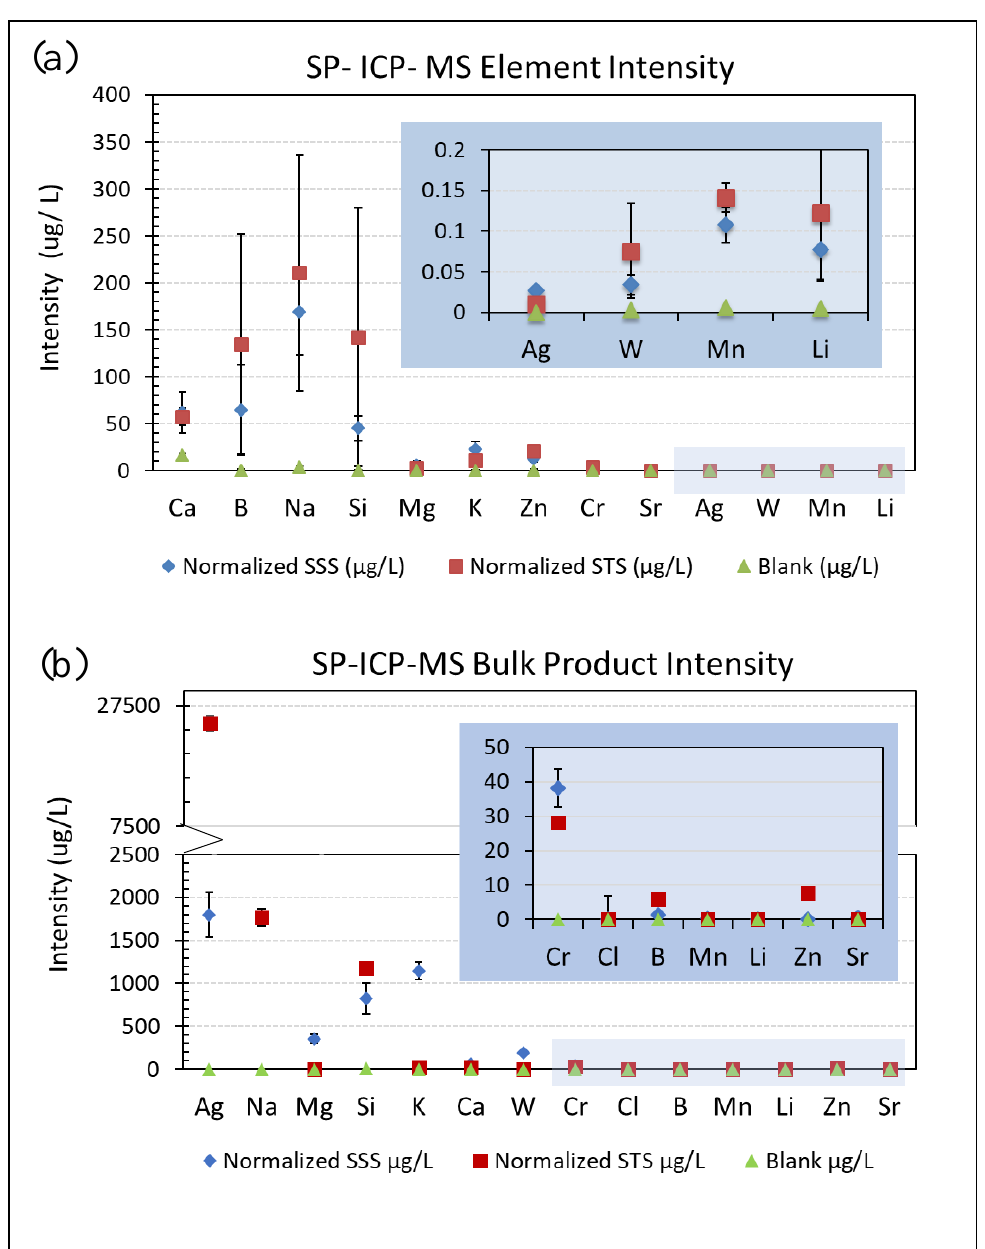
Figure 4. SP-ICP-MS average element intensity with standard error bars across three trials for SSS and STS impinger samples from the sprayed products ( a ) and the bulk products before spraying ( b ). ( a ) Aerosolized product Ag intensities were 0.0105 µ g / L for STS and 0.0273 µ g / L for SSS. Element intensities less than 0.2 µ g / L are indicated in the scaled area. ( b ) Bulk product Ag intensity was 24,567 µ g / L for STS and 1793 µ g / L for SSS. Element intensities less than 50 µ g / L are indicated in the area.